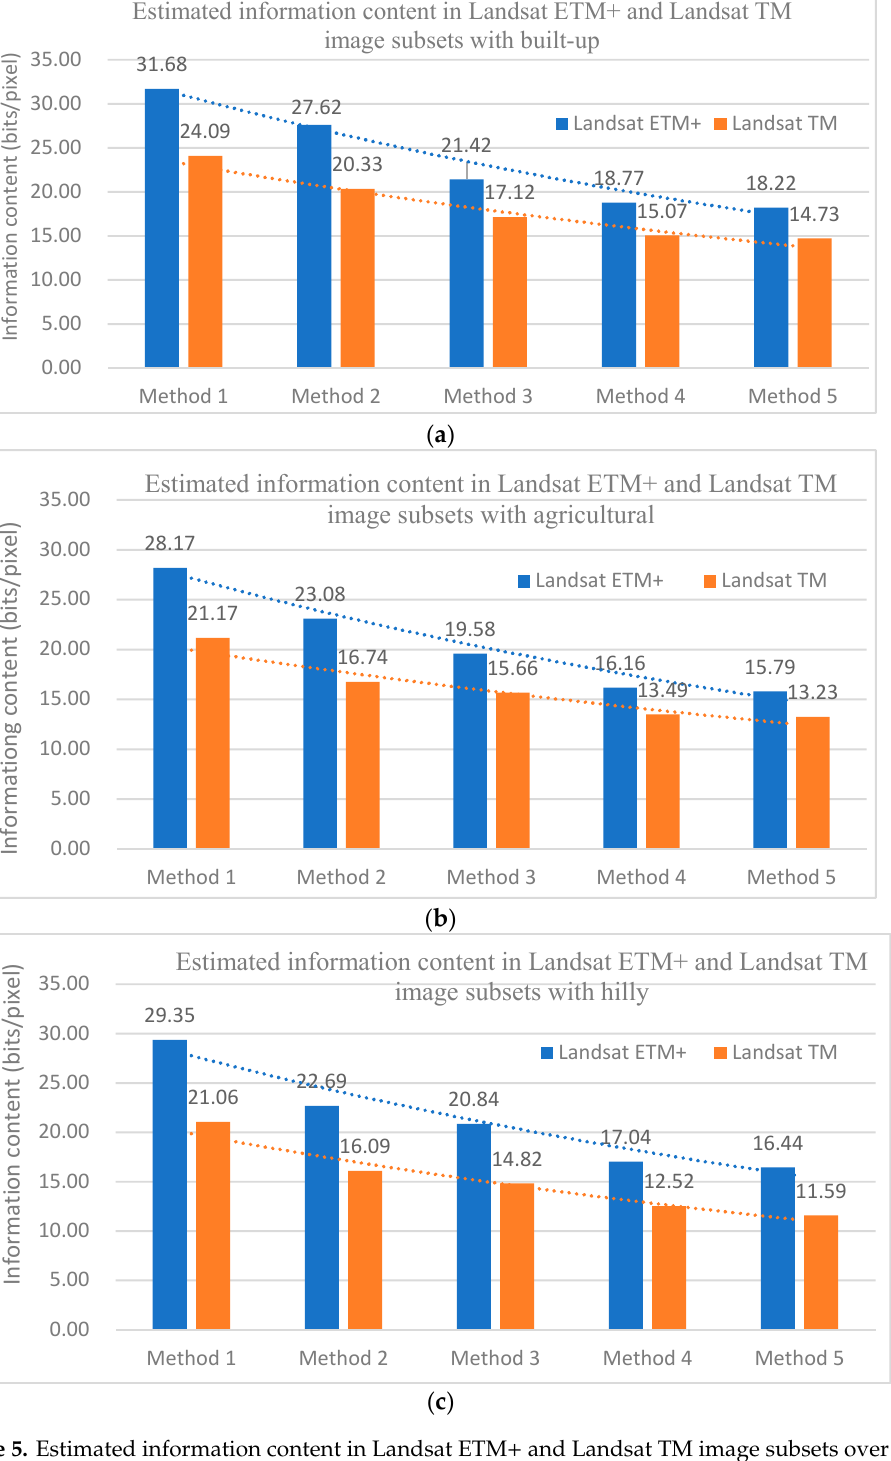
Figure 5. Estimated information content in Landsat ETM+ and Landsat TM image subsets over sites with different dominant land cover types: (a) built ‐ up, (b) agricultural, and, (c) hilly.